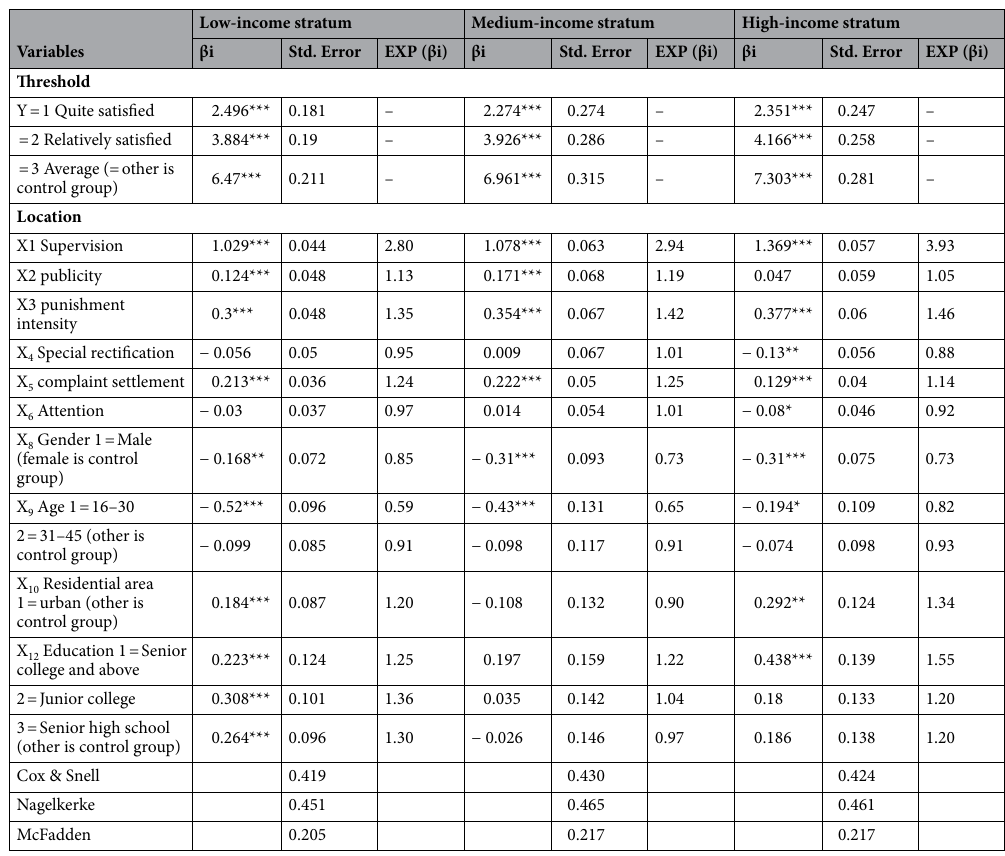
Table 8. Model (7) parameter estimates. Link function: